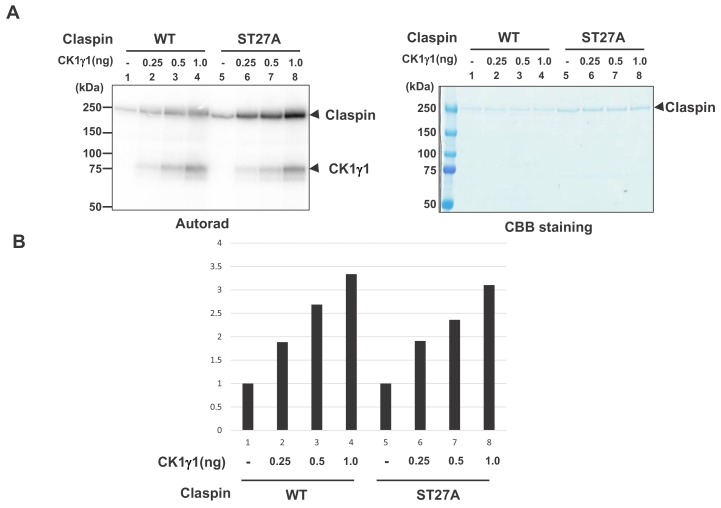
CK1γ1 phosphorylates Claspin in a manner independent of serine/threonine residues in the CKBD-AP segment.(A) Purified wild type Claspin or Claspin mutant ST27A (serines and threonines in aa903-1120 substituted by alanine) was incubated in the kinase reaction with indicated amounts of purified CK1γ1 in the presence of [γ-32P]-ATP. Samples were analyzed on 4–20% gradient SDS-PAGE, followed by CBB staining (right) and autoradiogram (left). The positions of the proteins are indicated by arrows. Bottom drawing shows schematic diagram of the polypeptide #27. (B) Quantification of the phosphorylation levels of the Wt or ST27A Claspin in A. The background phosphorylation level in the absence of CK1γ1 was taken as one for both WT and ST27A Claspin proteins.